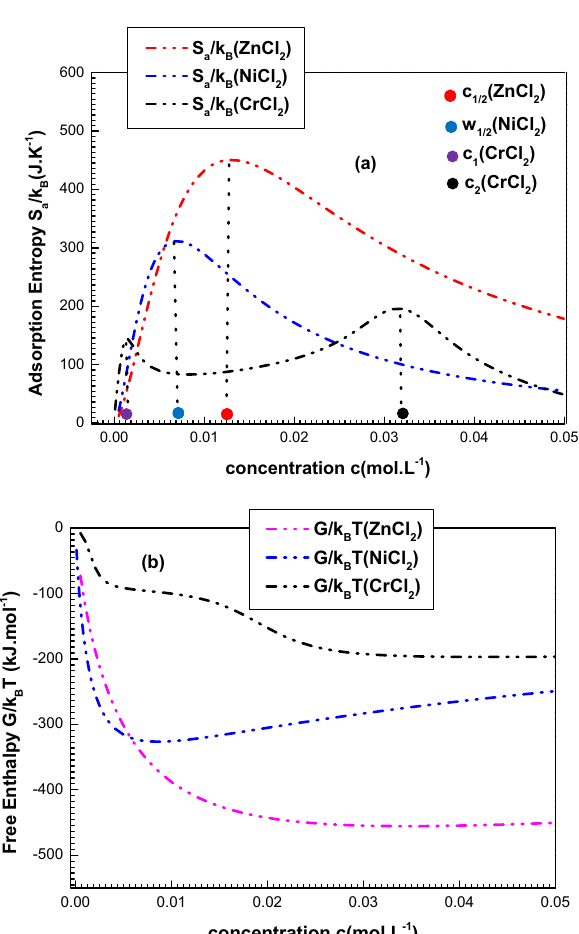
Figure 5. Evolutions of the entropy (a) and the free enthalpy (b) versus concentration for the three adsorption systems at 300